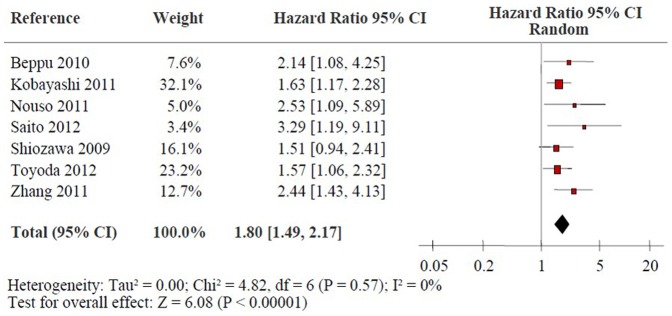
Forrest plot of the association between high pre-treatment serum AFP-L3% and DFS of HCC patients.Hazard ratio and associated 95% confidence interval were calculated. DFS: disease-free survival; AFP-L3: the lens culinaris agglutinin-reactive fraction of α-fetoprotein; HCC: hepatocellular carcinoma.